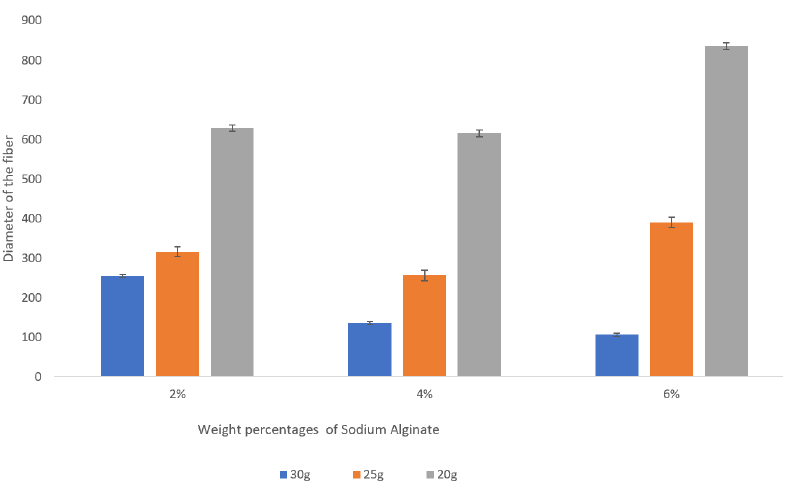
Figure 3. Dependence of the fiber diameter on the gauge of the needles for various concentrations of sodium alginate with the sodium alginate flow rate kept at 1 mL/min. The error bars represent the standard deviation of the measured diameters.